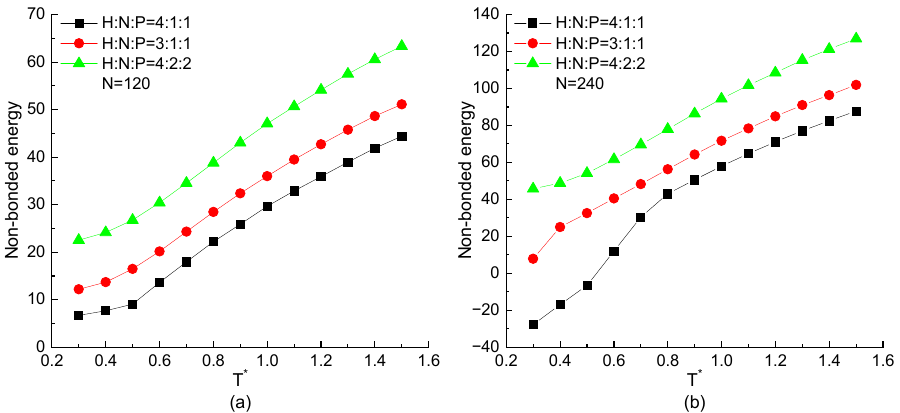
Figure 4. The non-bonded energy versus reduced temperature T * of H4N1P1, H3N1P1, and H4N2P2 proteins with chain length of ( a ) N = 120, ( b ) N = 240 .